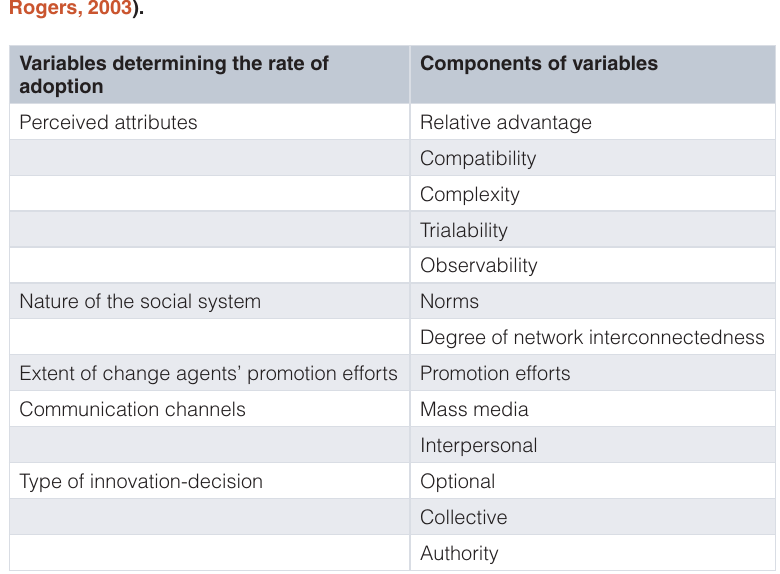
Table 2. Variables affecting the rate of adoption of an innovation (adapted from Rogers,